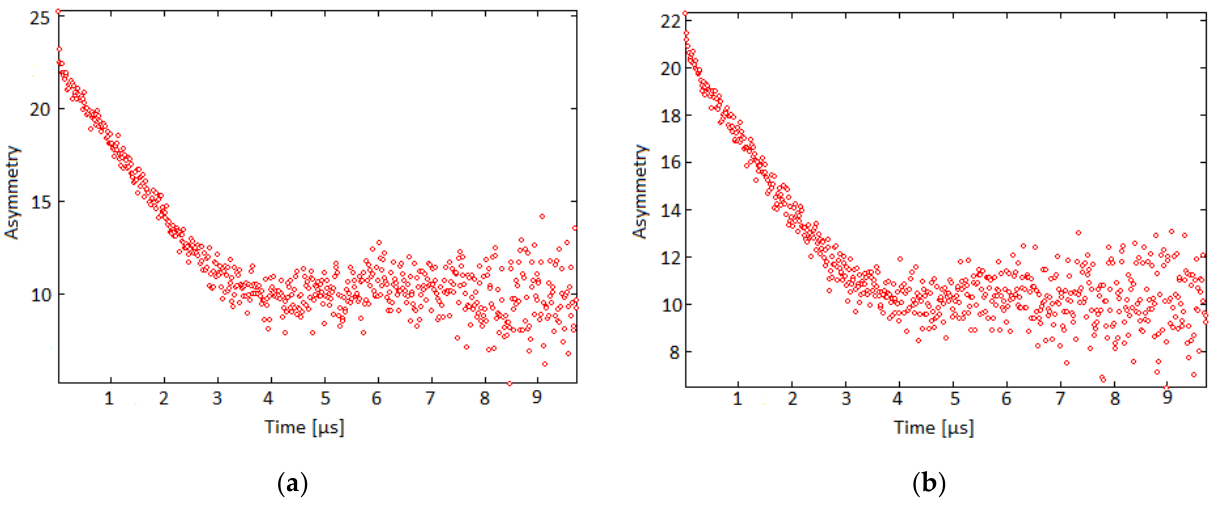
Figure 8. Time-dependent asymmetry for ( a ) sample 1 at 2.1 K; ( b ) sample 2 at 2.4 K. Both curves were fit with a non-relaxing component, a relaxing Lorentzian component, and a stretched exponential